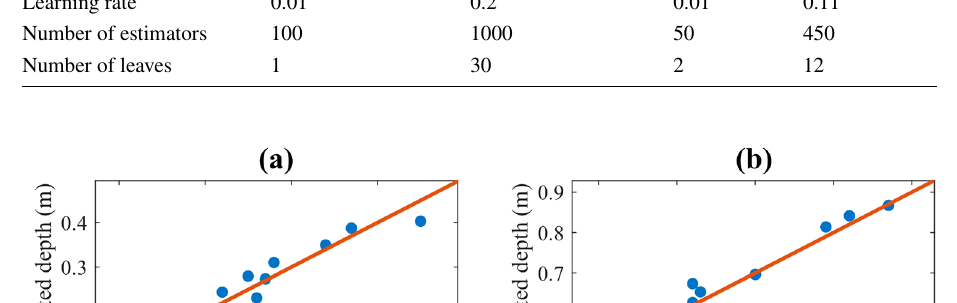
Table 4 The optimization range and optimum values of the light gradient boosting machine (LightGBM) model hyperparameters based on grid search (GS) algorithm